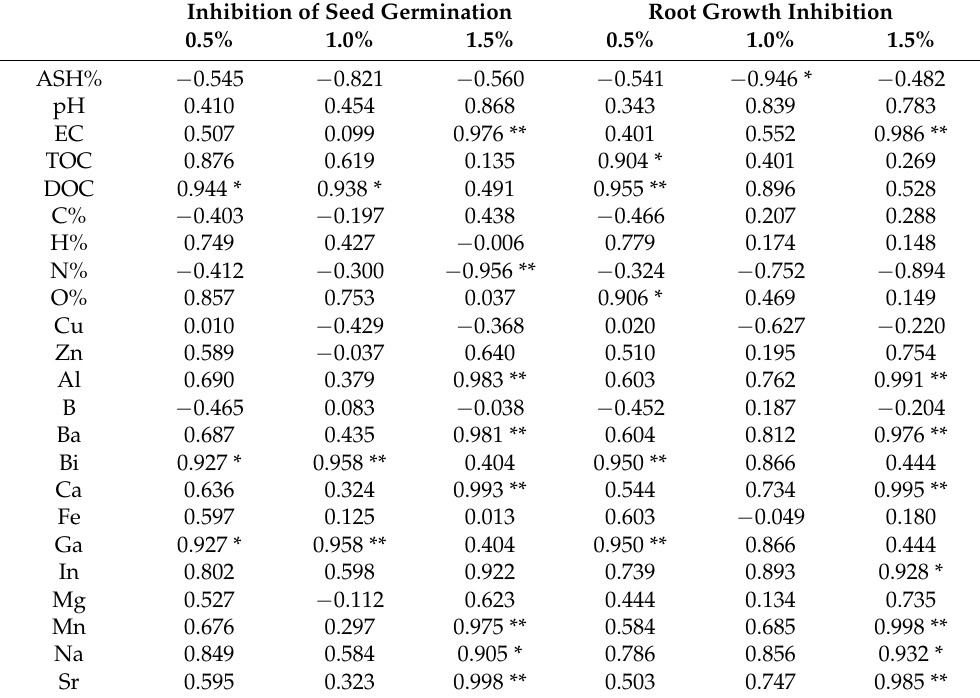
Table 4. Relationship between physicochemical properties and metals content in BCs and